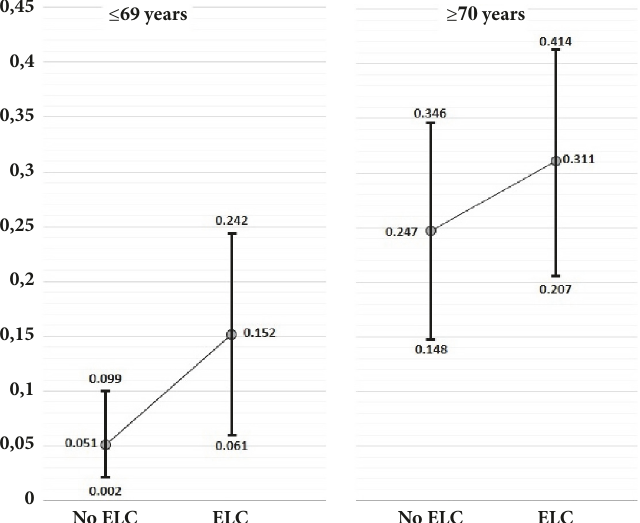
Figure 2: Probability margins of abnormal ankle index (ABI) determination according to earlobe crease (ELC) presence, with participants stratified by the median age of the population (69 years). In both age groups, the probability of abnormal ABI is higher among individuals with an ELC, but differences are not significant due to overlapping 95% confidence